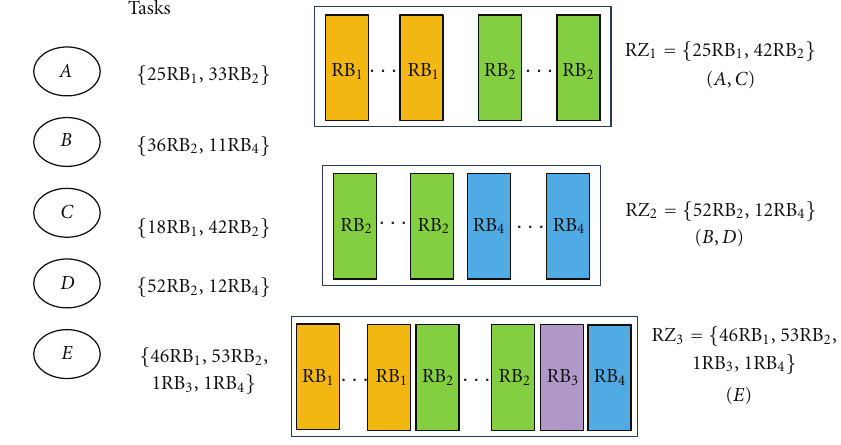
Figure 5: Example of the search for RZ